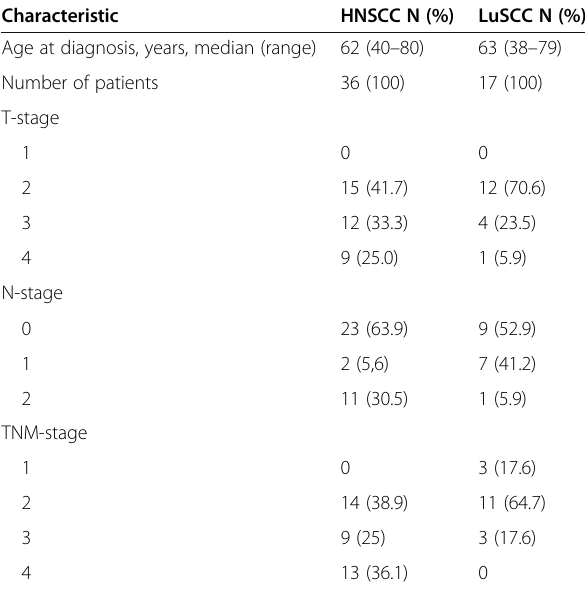
Table 1 Clinical characteristics of the study cohort. Data are presented as number (%) unless otherwise indicated